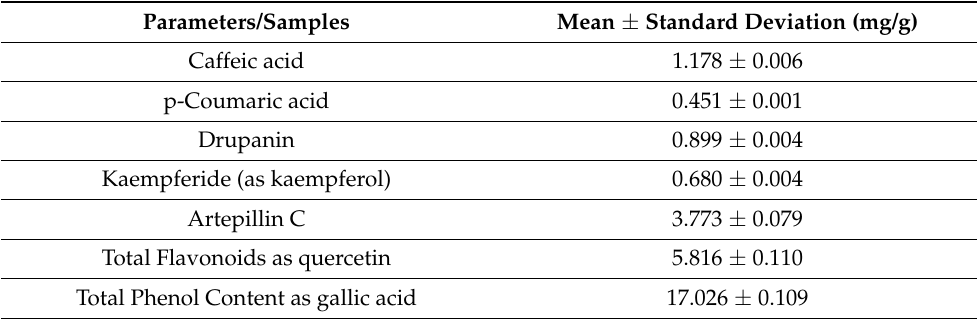
Table 1. Chemical characterization of BGP-AqExt (Propomax—0030 015 17) according to colorimetric and High-performance liquid chromatography (HPLC) methods.